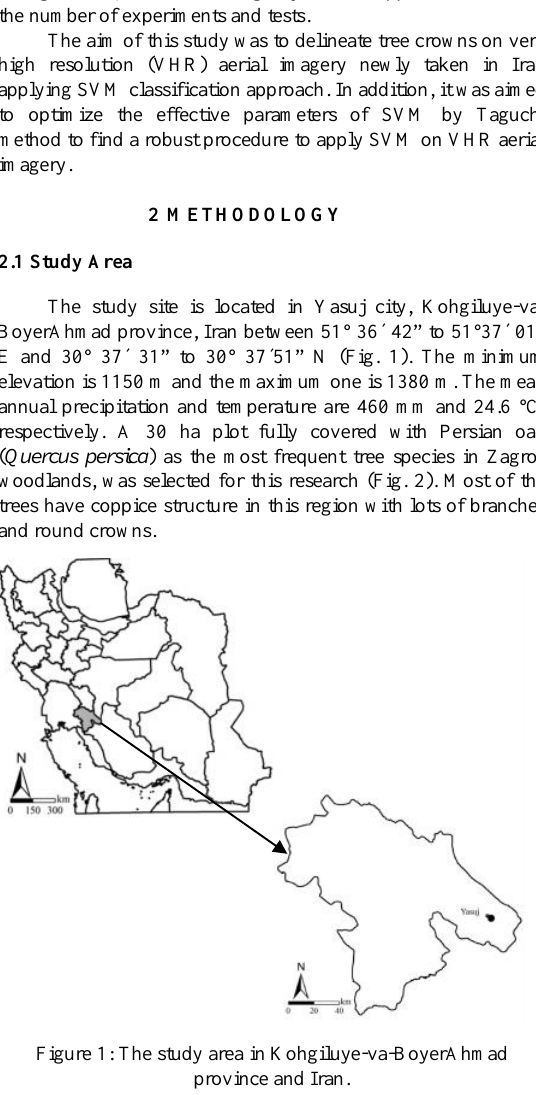
Figure 2: Persian oak trees in the study